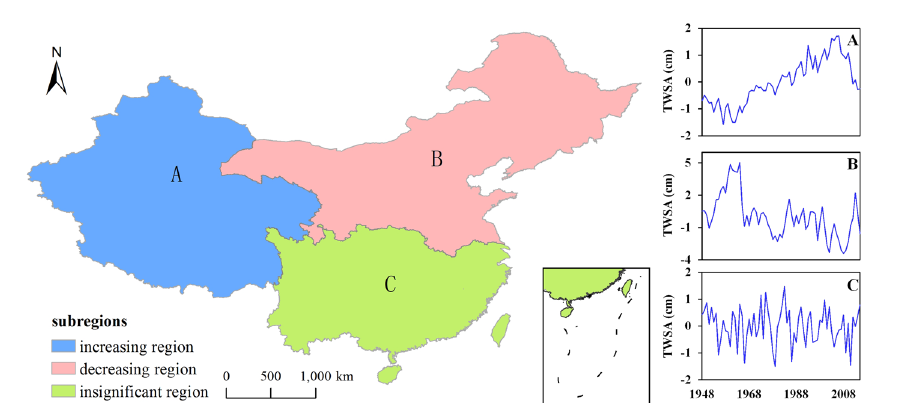
Figure 5. Spatial distributions of the TWS variation sub-regions: ( A ) increasing TWS region, ( B ) decreasing TWS region, and ( C ) the insignificant change region. This map was created using ArcGIS 10.1 software, visit http://desktop.arcgis.com/en/ for more